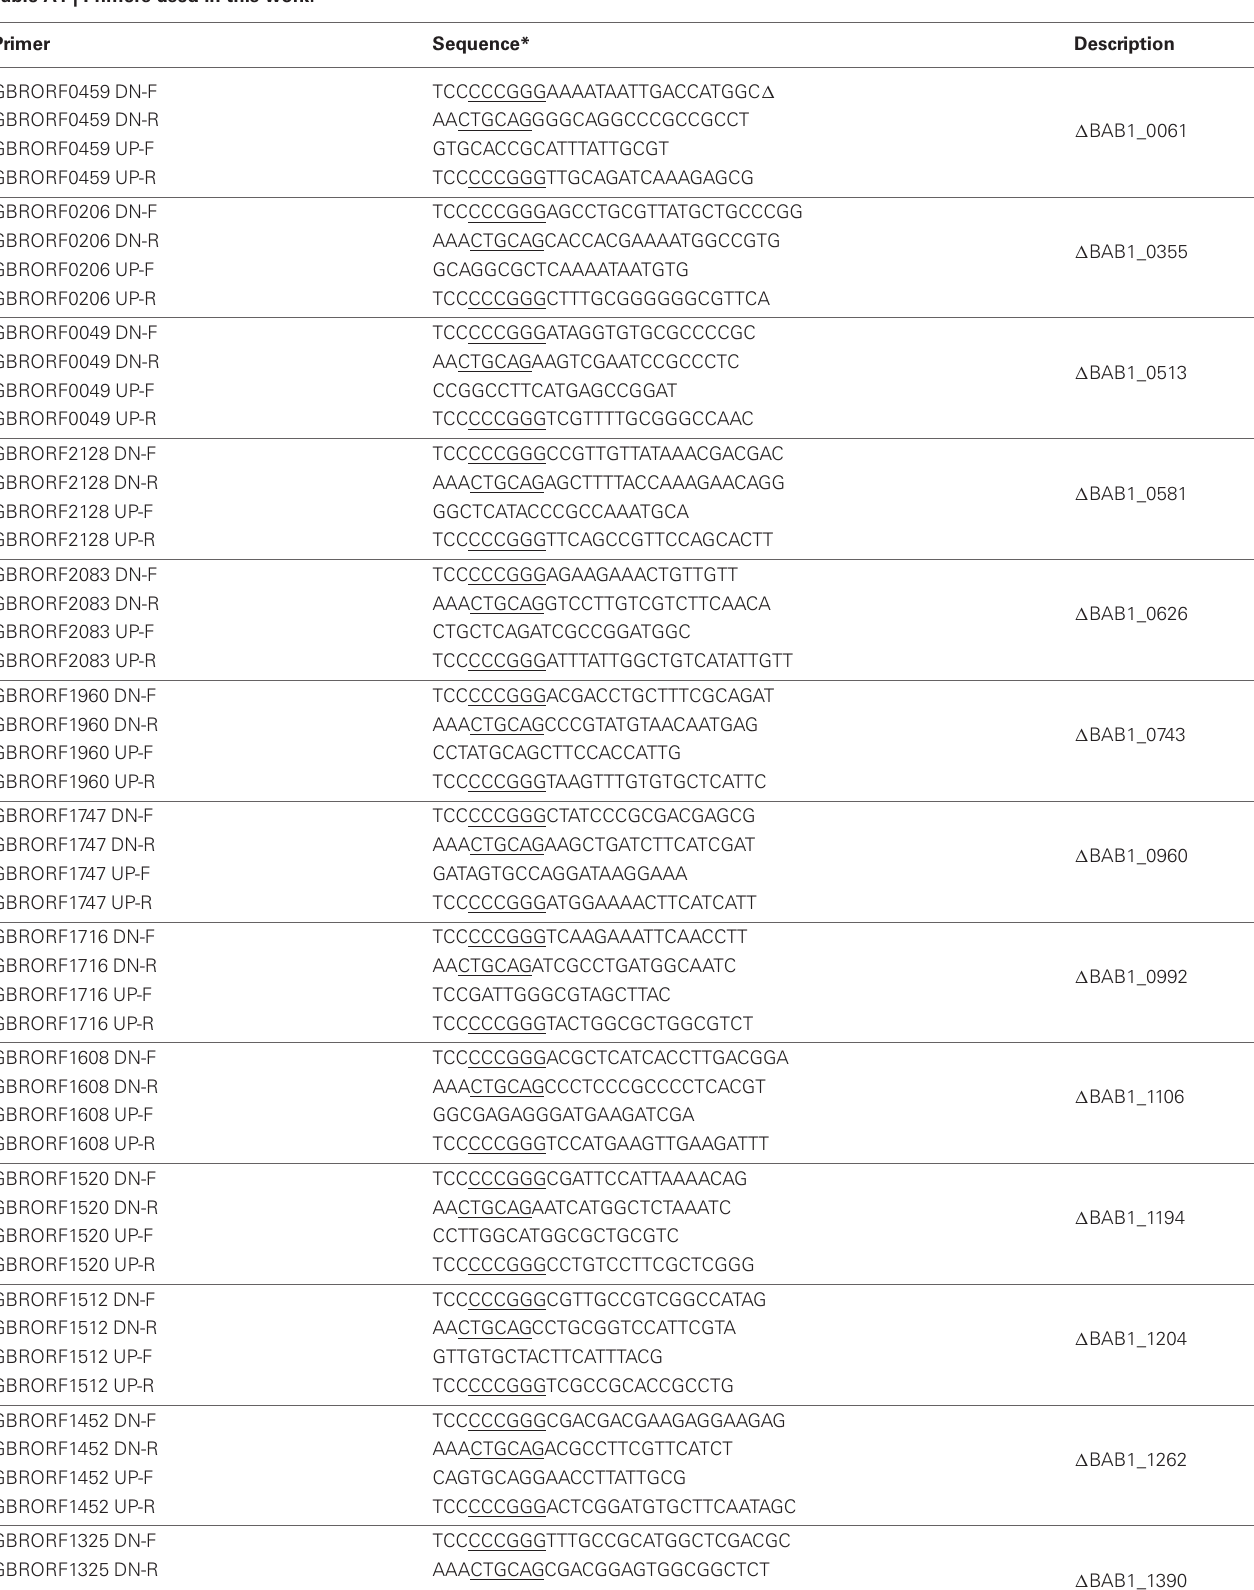
Table A1 | Primers used in this